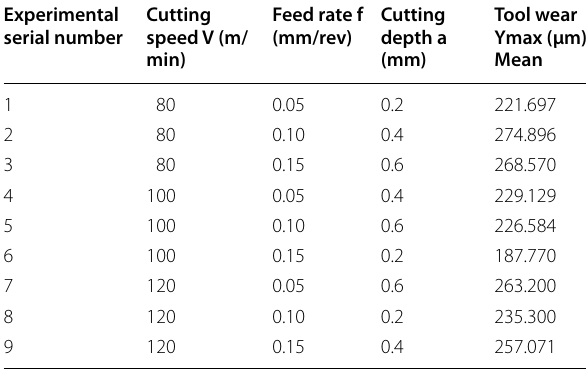
Table 4 Experimental results for wear of tool insert Experimental Cutting serial number speed V (m/